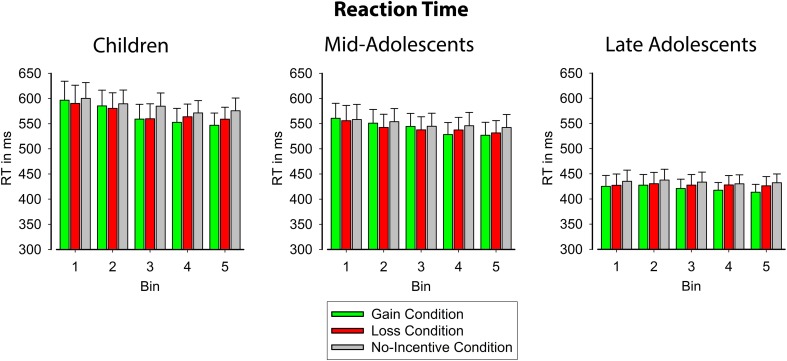
Learning-related changes in reaction time for the three incentive conditions, displayed separately for children (left), younger adolescents (middle), and older adolescents (right). The x-axis shows the course of learning averaged into 5 bins. Error bars indicate standard error.